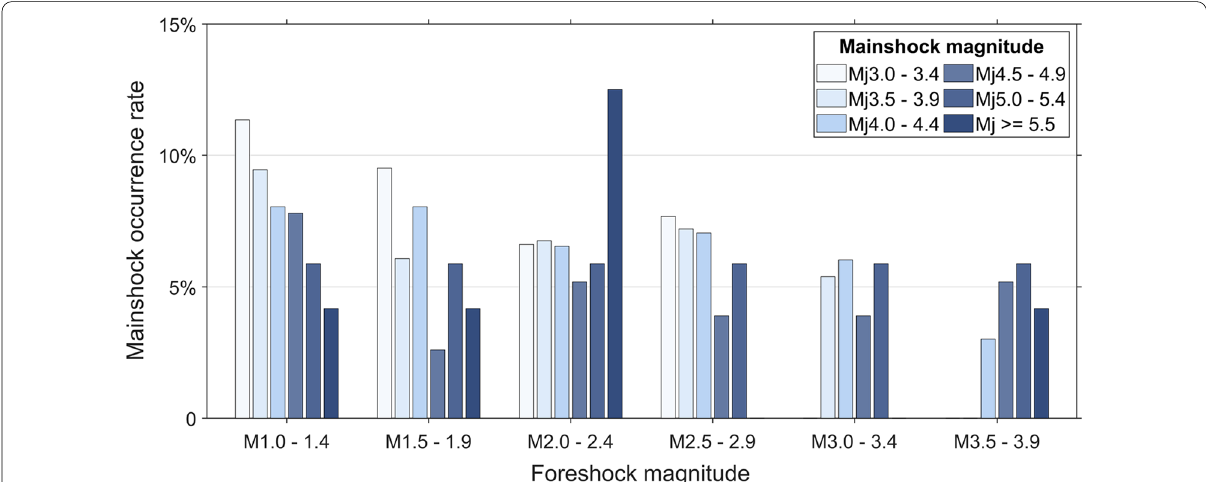
Fig. 7 Relations between the magnitudes of foreshocks and mainshocks, shown by the percentage of mainshock occurrence rate for each foreshock and mainshock magnitude